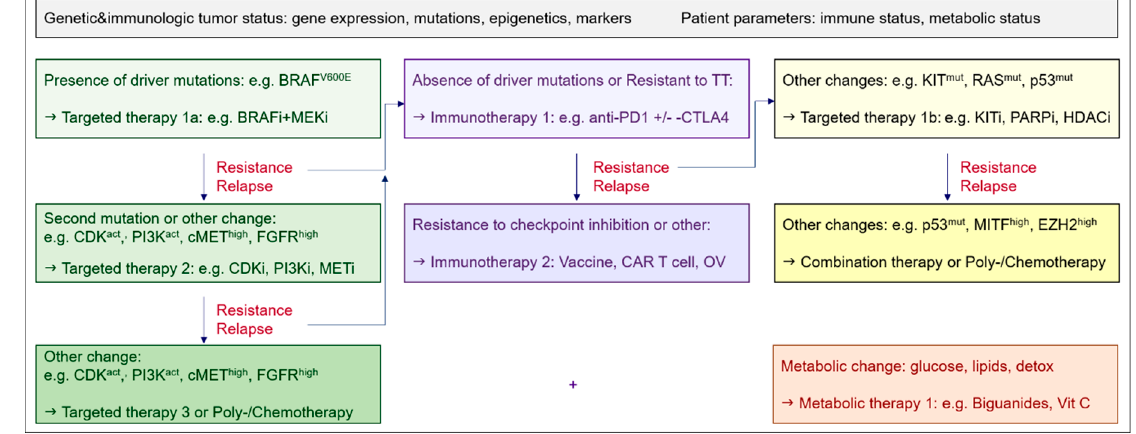
Figure 2. Algorithm suggestion for therapy decisions based on the assessment of the tumor genetic and immunologic status and patient parameters for the example of metastatic melanoma.